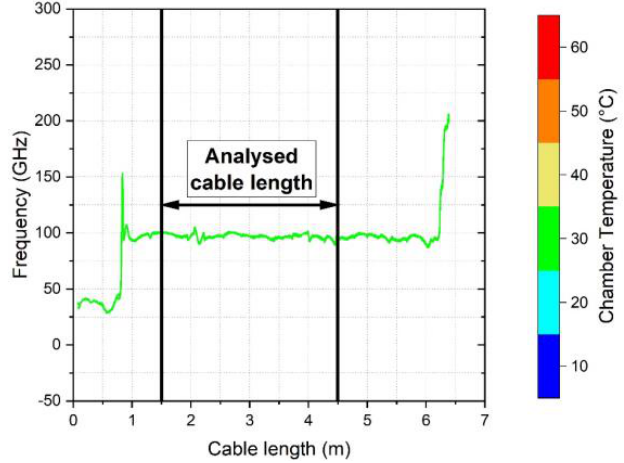
Figure 5. Representation of the selected 3.0 m cable length used to analyse the temperature calibration factor. Peaks at the 1.0 m and 6.2 m show the position where the cable is fed into the chamber and the end of the cable, respectively.